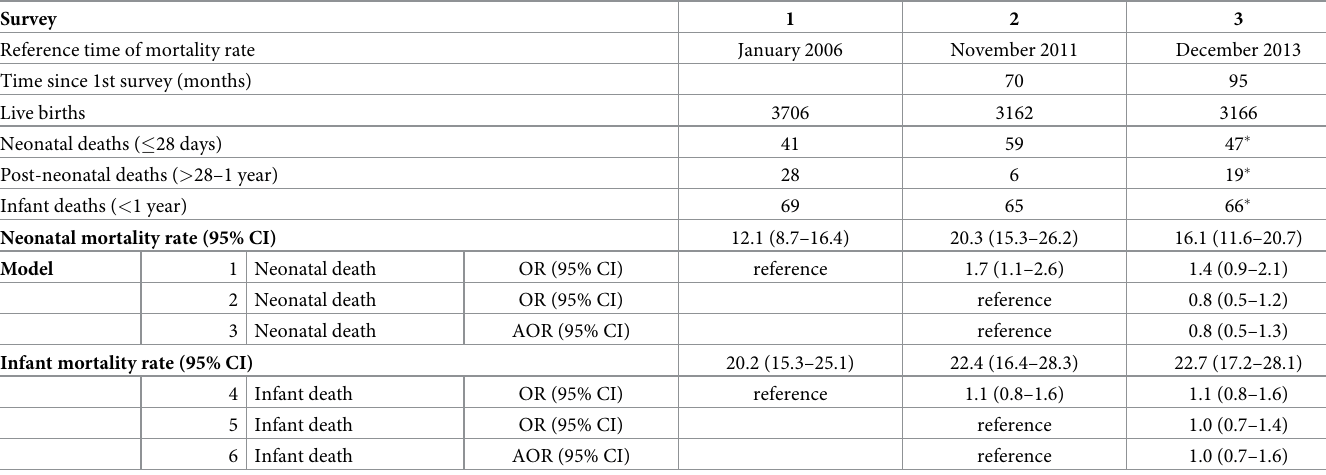
Table 2. Neonatal and infant mortality compared to previous